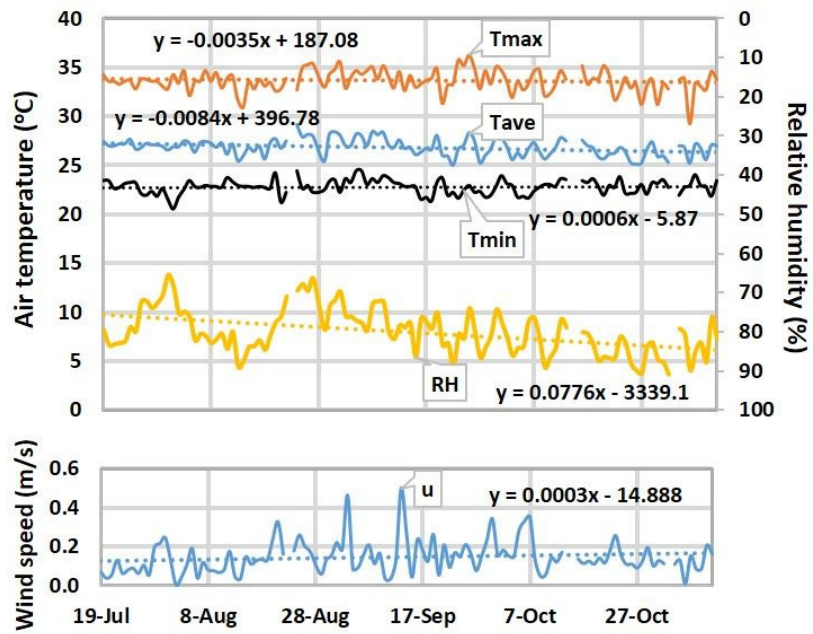
Figure 2. Air temperature, relative humidity, and wind speed fluctuations during planting season. On the other hand, the relative humidity was found to decrease slightly. The gradient value was higher than the linear equations of air temperature; however, the value was low (<0.1). During one growing season, the consecutive minimum, average and maximum relative humidity values were 65.4%, 80.1%, and 91.0%, respectively. For the wind speed, the fluctuation was between 0 and 0.5 m/s, which indicated low wind speed in the field location (<1 m/s). In addition, its gradient was also relatively low (<0.01) by means there that even fluctuated; however, there was no significant change in the trends. The minimum, average and maximum wind speed values were 0, 0.1, and 0.5 m/s, respectively. Another parameter, solar radiation, also showed a slightly decreasing trend, as de- picted in Figure 3. The reference evapotranspiration is also presented in the figure. At the beginning of the growing season, solar radiation reached around 15 MJ/m 2 /d with reference evapotranspiration of 3 mm. Then, the reference evapotranspiration and solar radiation fluctuated; however, the trend was similar to other weather parameters. The gradient of the linear equation was low (<0.01), which represented no significance in raising and decreasing those parameters. At the end of the season, the value of solar radiation was around 14 MJ/m 2 /d with reference evapotranspiration being lower than 3 mm. The maxi- mum, average and minimum values of solar radiation were 19.9, 14.1 and 5.9 MJ/m 2 /d, respectively. At the same time, the reference evapotranspiration values were 1.1, 2.9, and 4.2 mm for minimum, average and maximum,